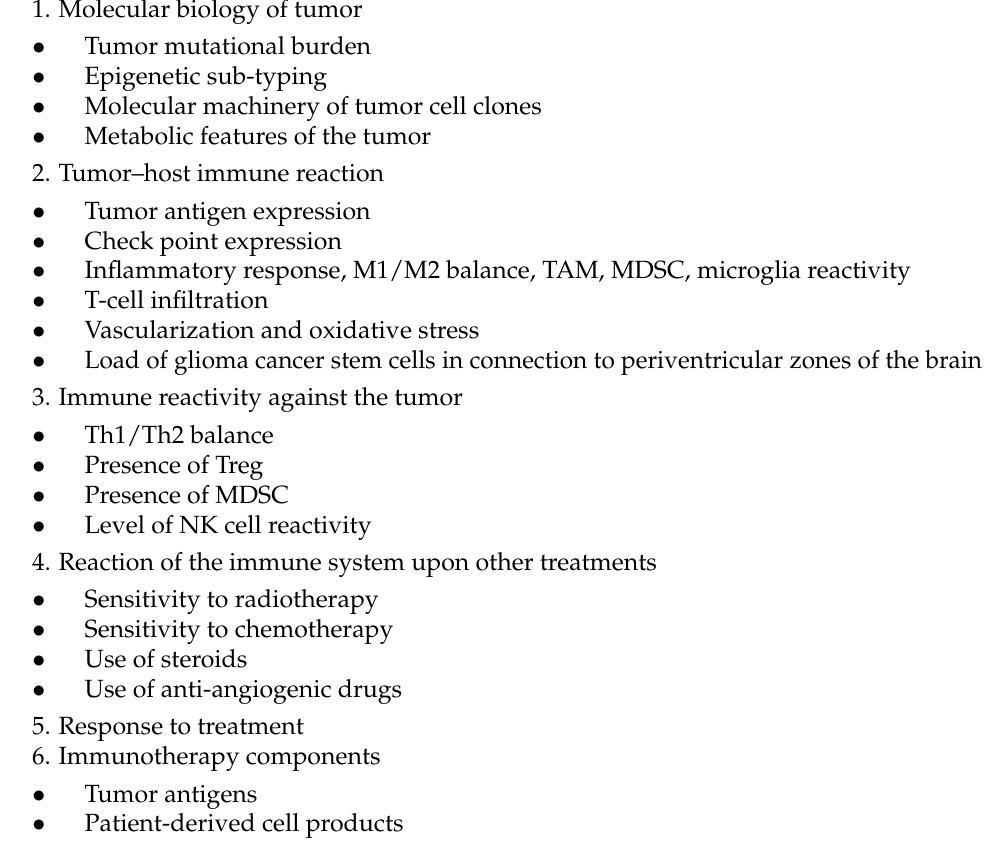
Table 2. Levels of personalized medicine for Glioblastoma Multiforme